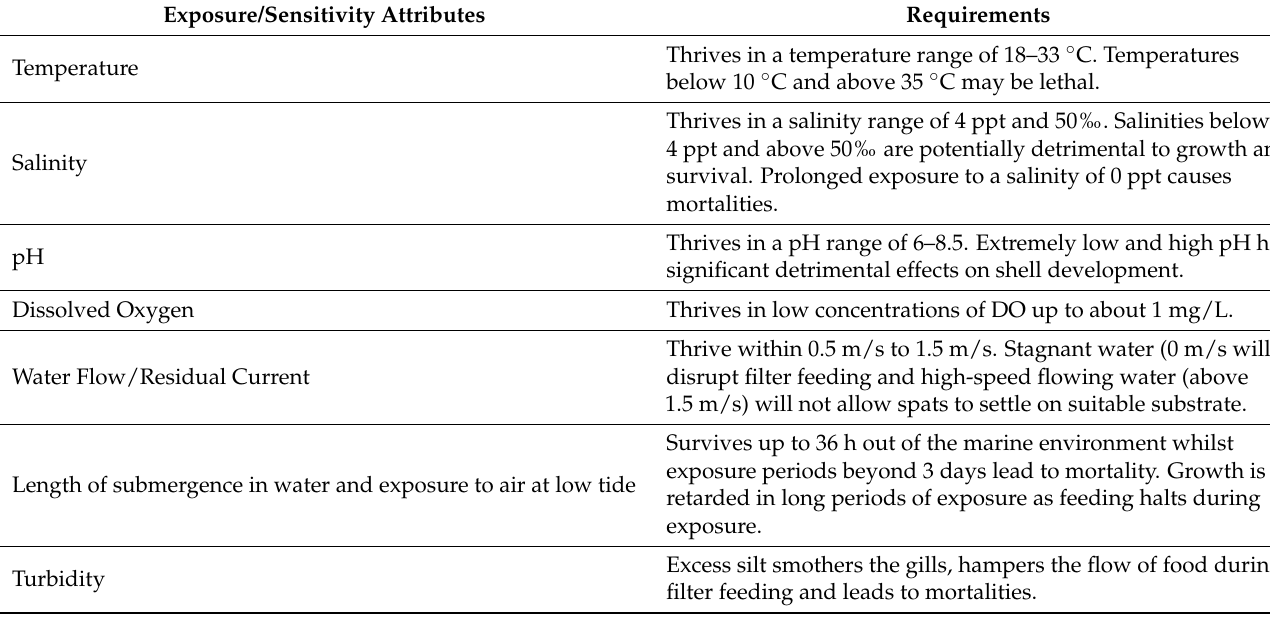
Table 2. Summary of species profile developed for C. tulipa for the